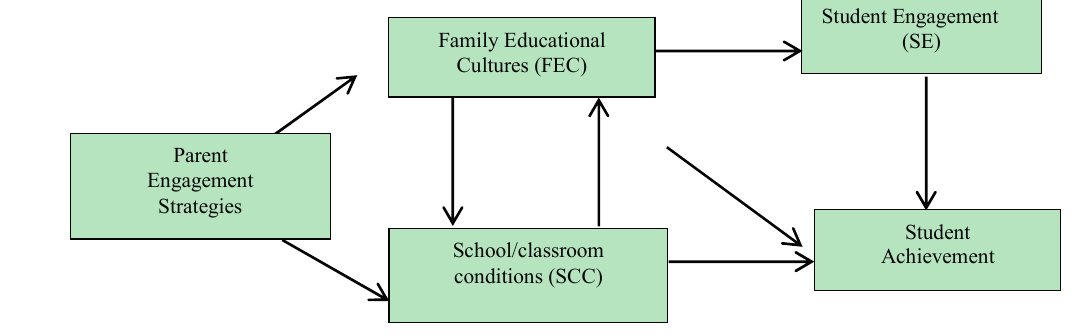
Figure 1. The Project’s Theory of